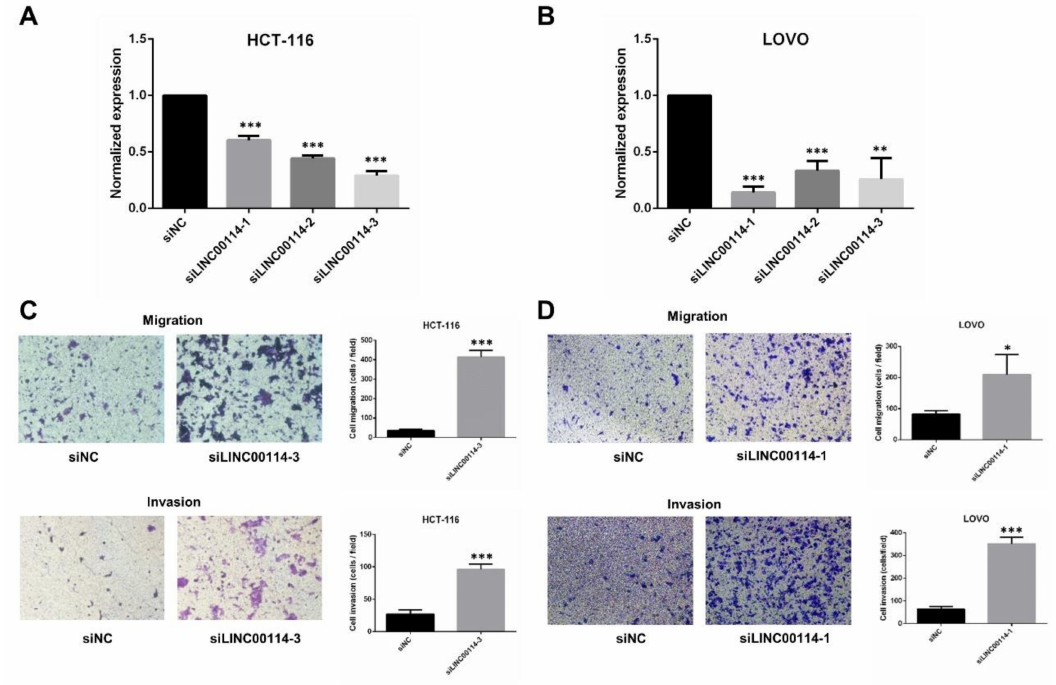
Figure 7. LINC00114 represses CRC cell migration. ( A , B ) LINC00114 expression levels were determined in negative control or siRNA-transfected HCT-116 or LOVO cells by qRT-PCR. Expression levels were normalized to GAPDH , and the results were expressed as the fold increase relative to negative control. ( C , D ) Transwell assays were used to determine the role of LINC00114 siRNA in HCT-116 or LOVO cell migration and invasion. All data are expressed as mean ± standard deviation (SD) of three independent experiments; * p < 0.05, ** p < 0.01, *** p <